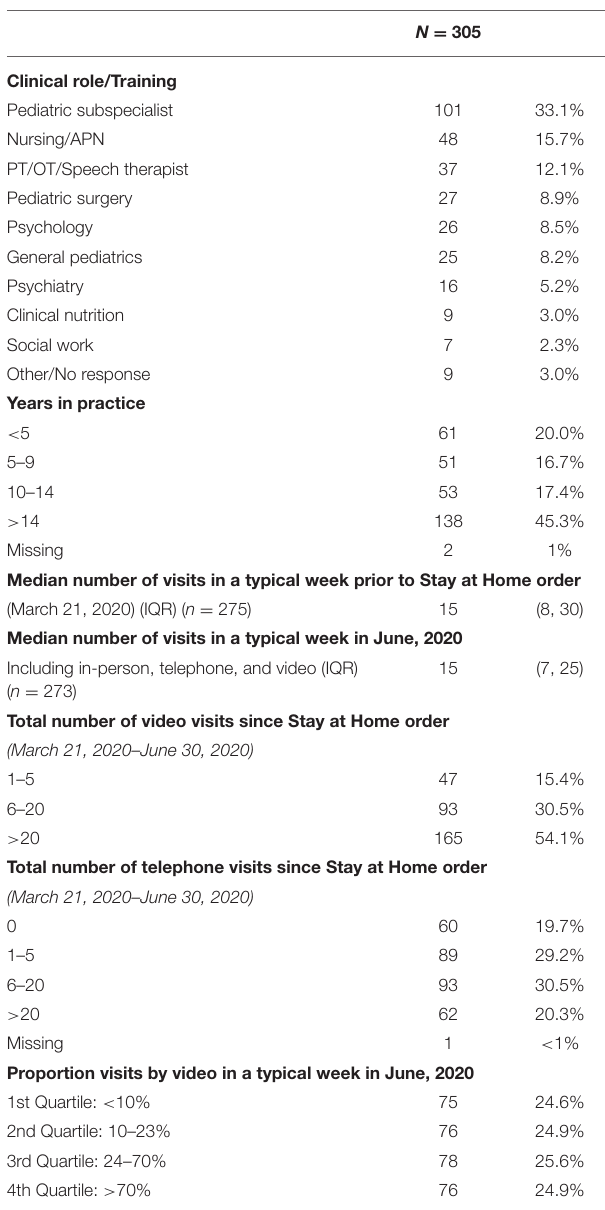
TABLE 1 | Respondent